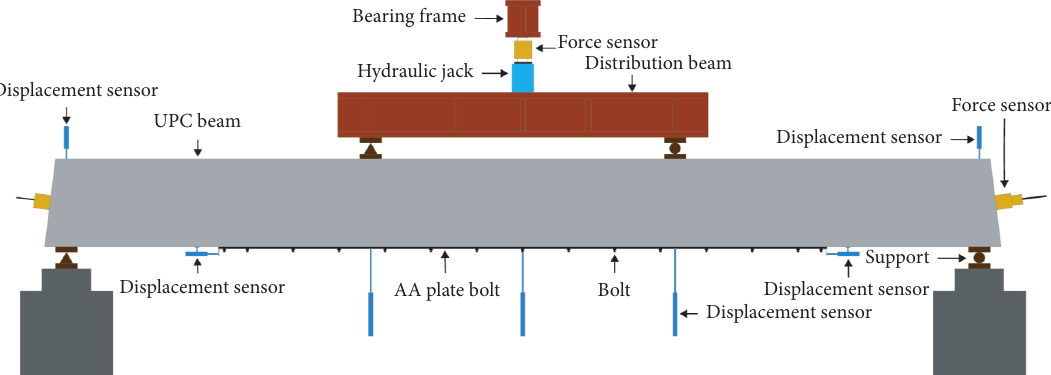
Figure 4: Loading device.